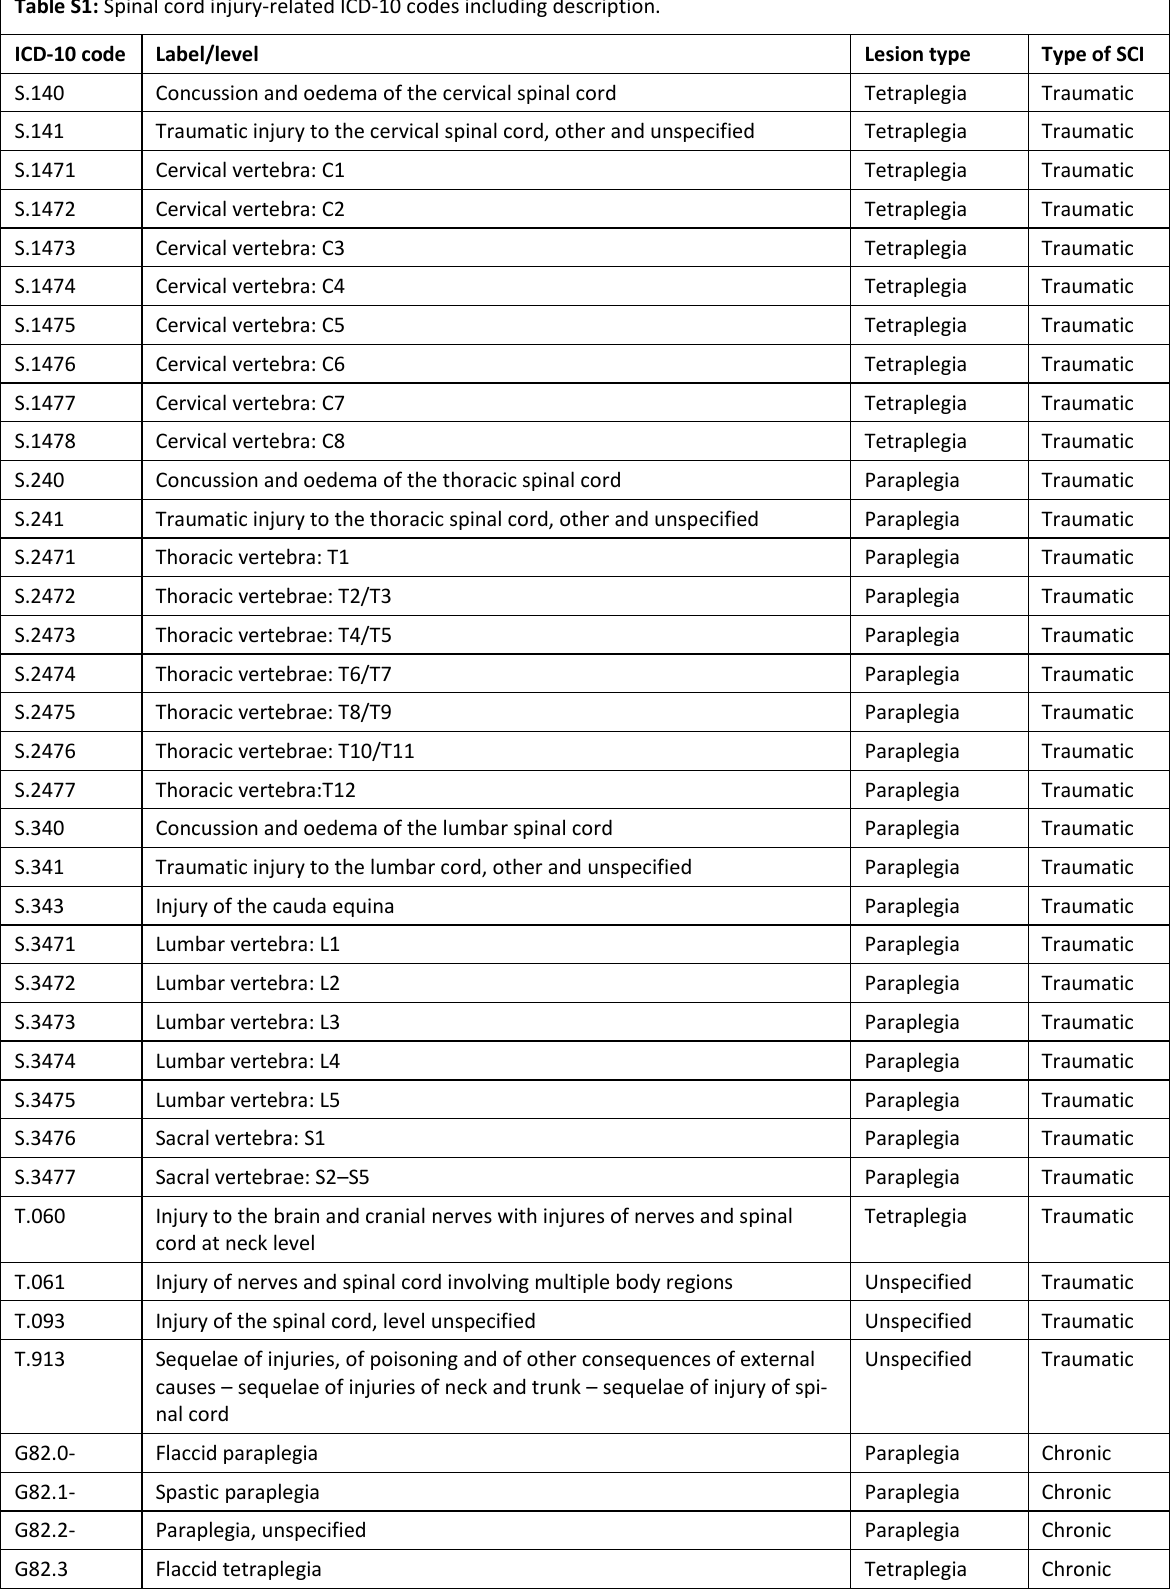
Table S1: Spinal cord injury-related ICD-10 codes including description. ICD-10